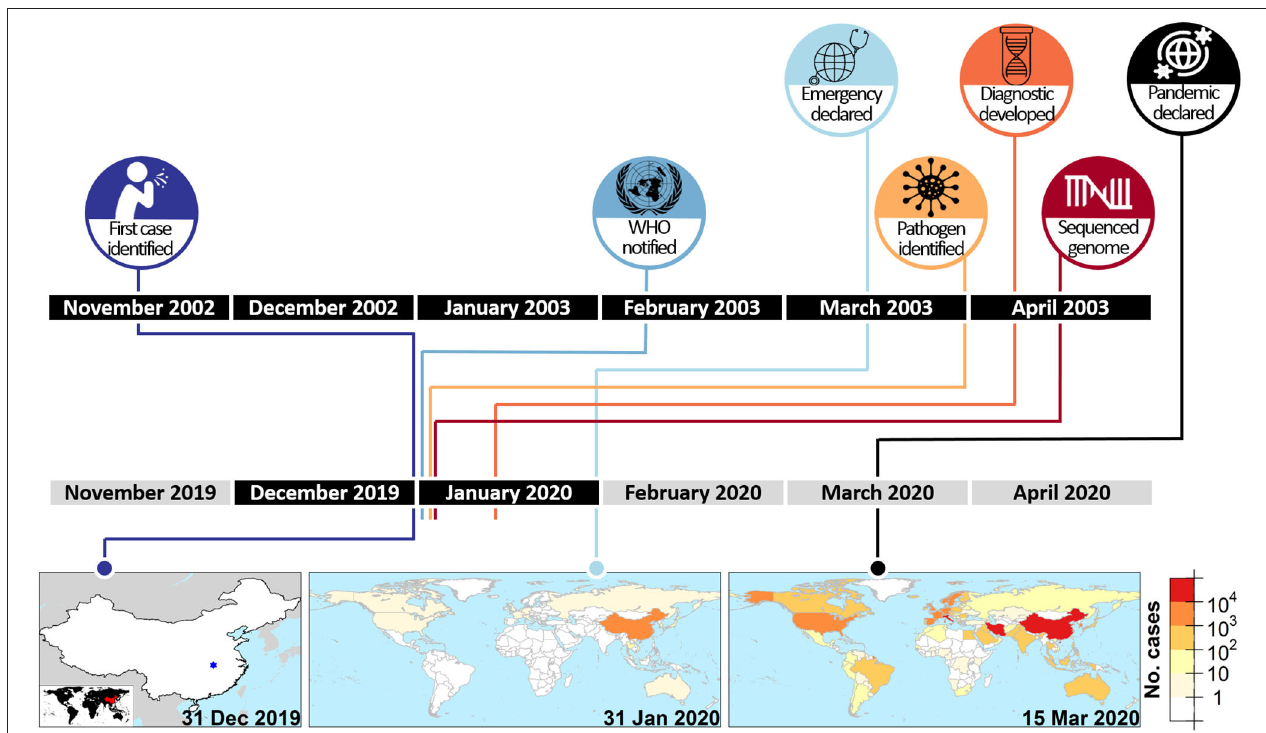
FIGURE 1 | Comparative timelines of two coronavirus epidemics. The relative timelines for SARS-CoV epidemic of 2002–2003 (top row) (14–19) and SARS-CoV-2 pandemic of 2019 (bottom row) ( 20–22), specifically highlighting dramatic differences in duration to notification of the WHO, identification of the pathogen and sequencing of the pathogen genome after the identification of the first case. The maps show the spatial extent of SARS-CoV-2 infection at three critical time points (23,